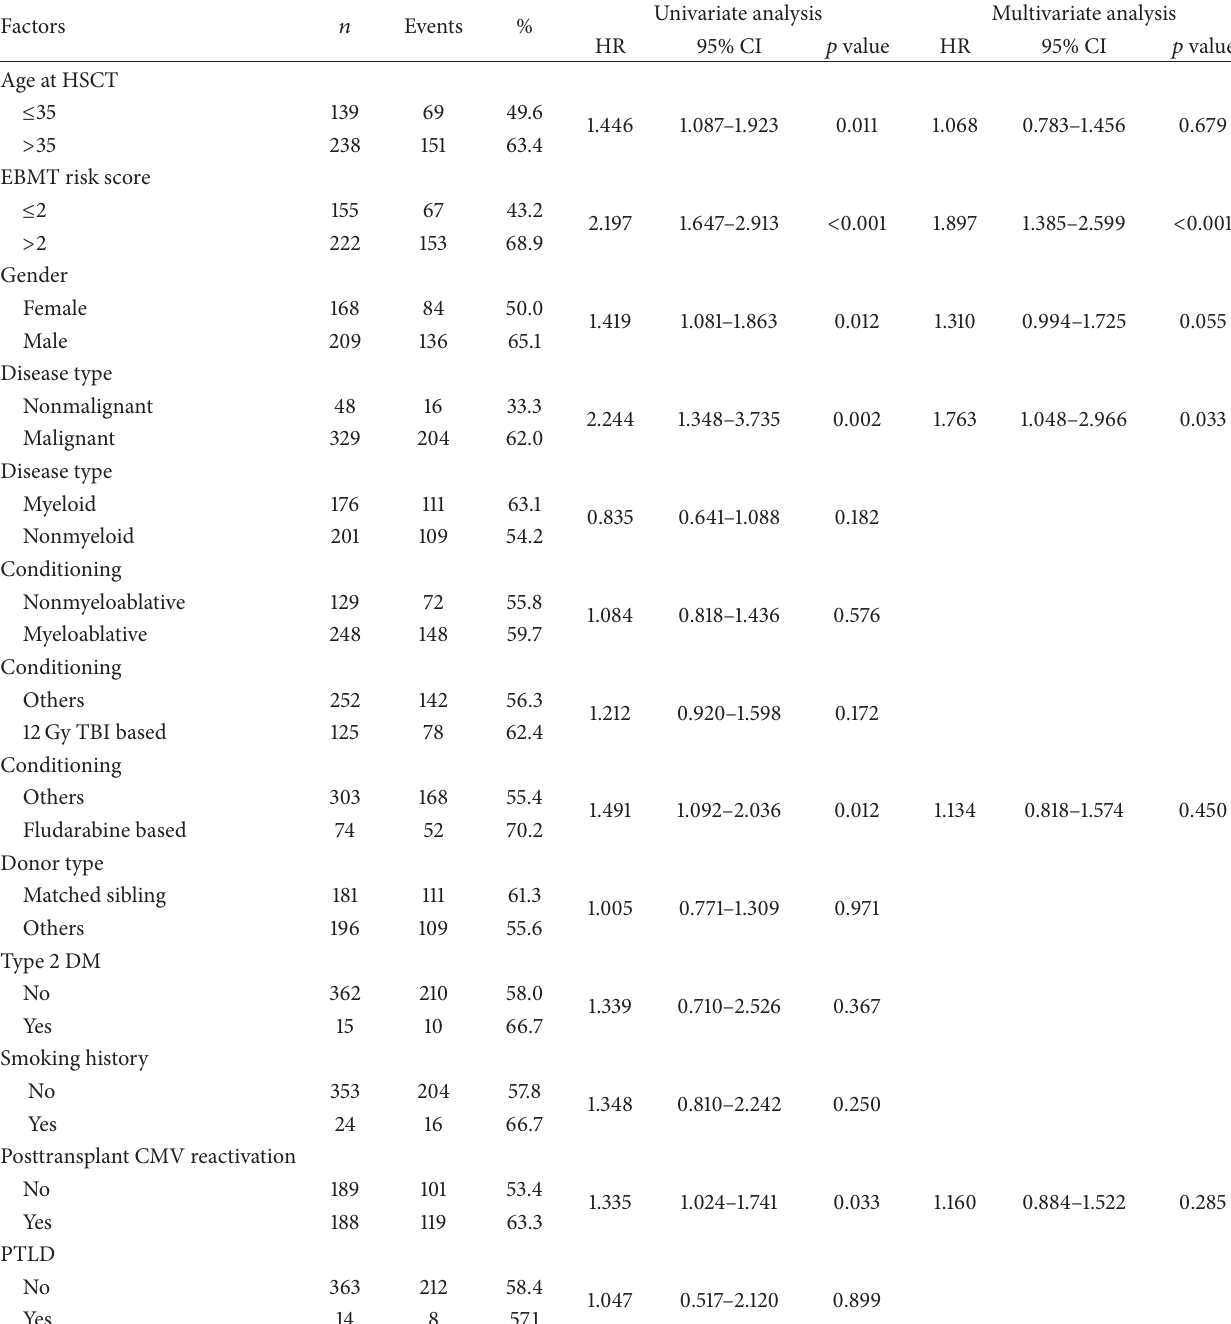
Table 2: Prognostic factors for 1-year GRFS after adult allogeneic